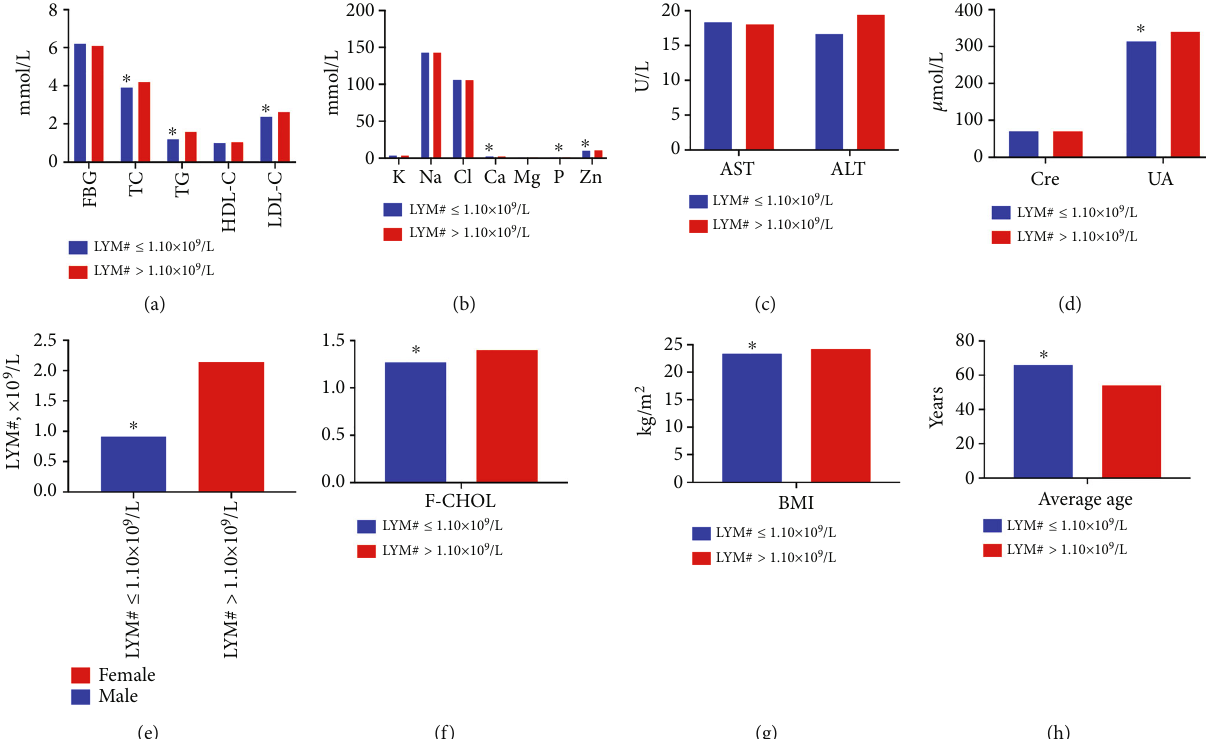
Figure 2: Comparison of di ff erent indicators between the LYM# ≤ 1 : 10 × 10 9 /L and LYM#>1 : 10 × 10 9 /L groups. (a) Comparison of levels of FBG, TC, TG, HDL-C, and LDL-C between the two groups. The levels of TC, TG, and LDL-C in LYM# ≤ 1 : 10 × 10 9 /L group were signi fi cantly lower than that in LYM#>1 : 10 × 10 9 /L group. (b) Comparison of levels of K, Na, Cl, Ca, Mg, P, and Zn in the blood between the two groups. The levels of blood Ca, P, and Zn were signi fi cantly lower in the LYM# ≤ 1 : 10 × 10 9 /L group than that in the LYM#>1 : 10 × 10 9 /L group. (c) Comparison of AST and ALT levels between the groups. (d) Comparison of Cre and UA levels between the groups. The levels of UA in LYM# ≤ 1 : 10 × 10 9 /L group were signi fi cantly lower than that in LYM#>1 : 10 × 10 9 /L group. (e) The LYM# in LYM# ≤ 1 : 10 × 10 9 /L group was signi fi cantly lower than that in LYM#>1 : 10 × 10 9 /L group. (f) The F-CHOL of patients in LYM# ≤ 1 : 10 × 10 9 /L group was signi fi cantly lower than that in LYM#>1 : 10 × 10 9 /L group. (g) The BMI of patients in the LYM# ≤ 1 :